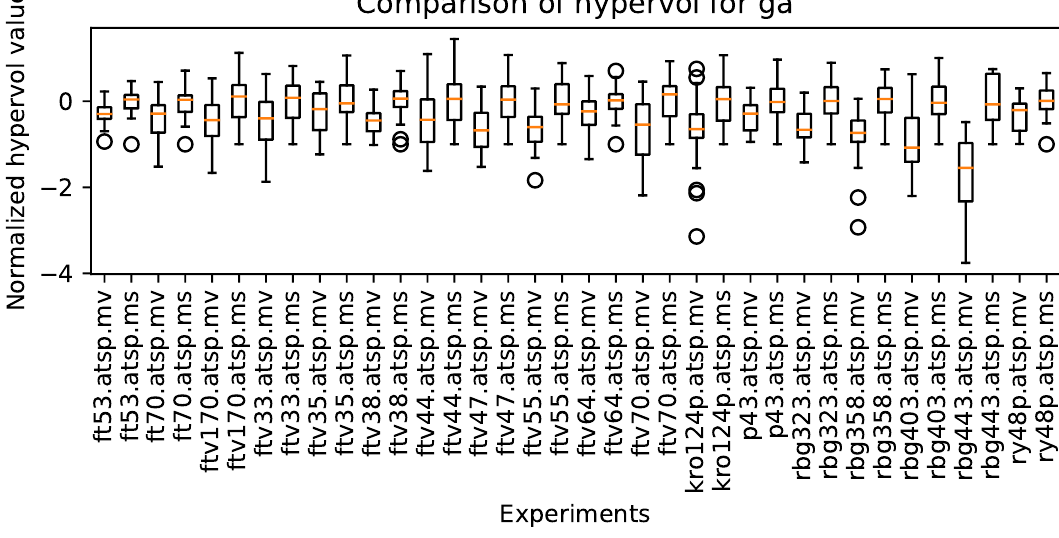
Figure 3. Boxplot of hypervolume across the 25 runs for each instance problem using Multistart and Multiverse GEnetic Algorithm methods. Hypervolumes are normalized to the corresponding average using Multistart so that they are comparable.